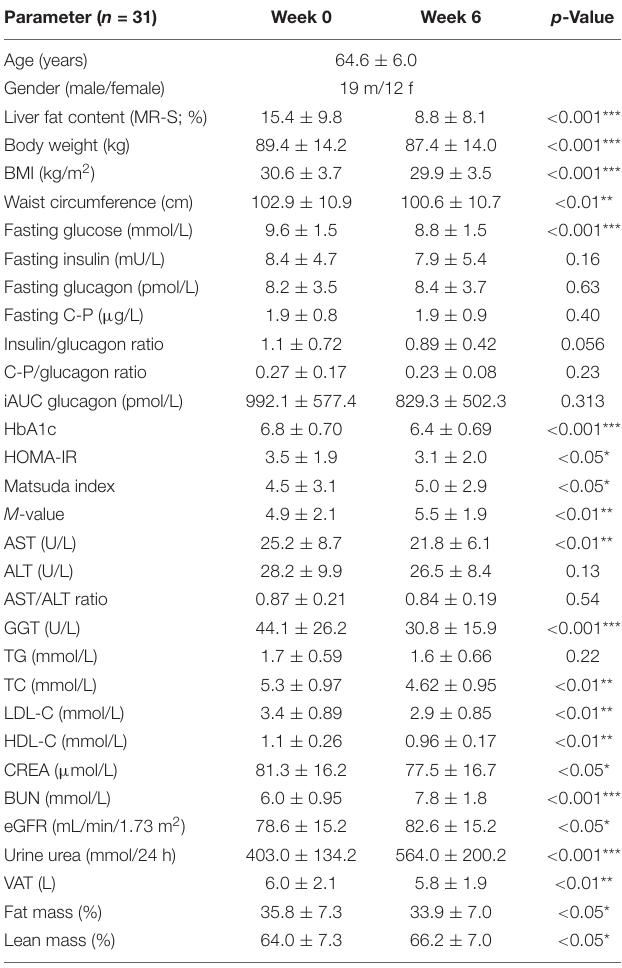
TABLE 1 | Parameters at baseline (Week 0) and after the HPD intervention of all study participants (Week 6). Parameter ( n =